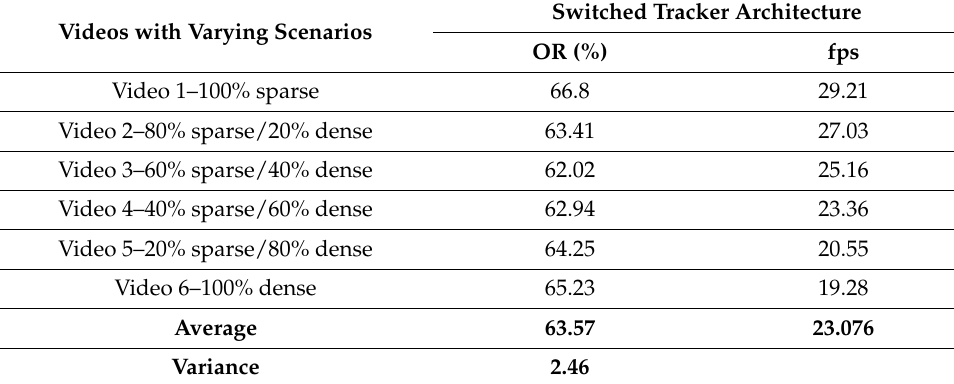
Table 7. Performance of fusion logic with switched trackers.